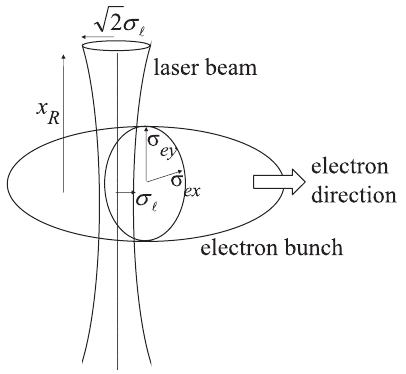
FIG. 11. Principle of operation of the laser-wire scanner with the key dimensions labeled. The figure shows the laser config- ured to scan the horizontal x -profile of the electron bunch (cid:2)